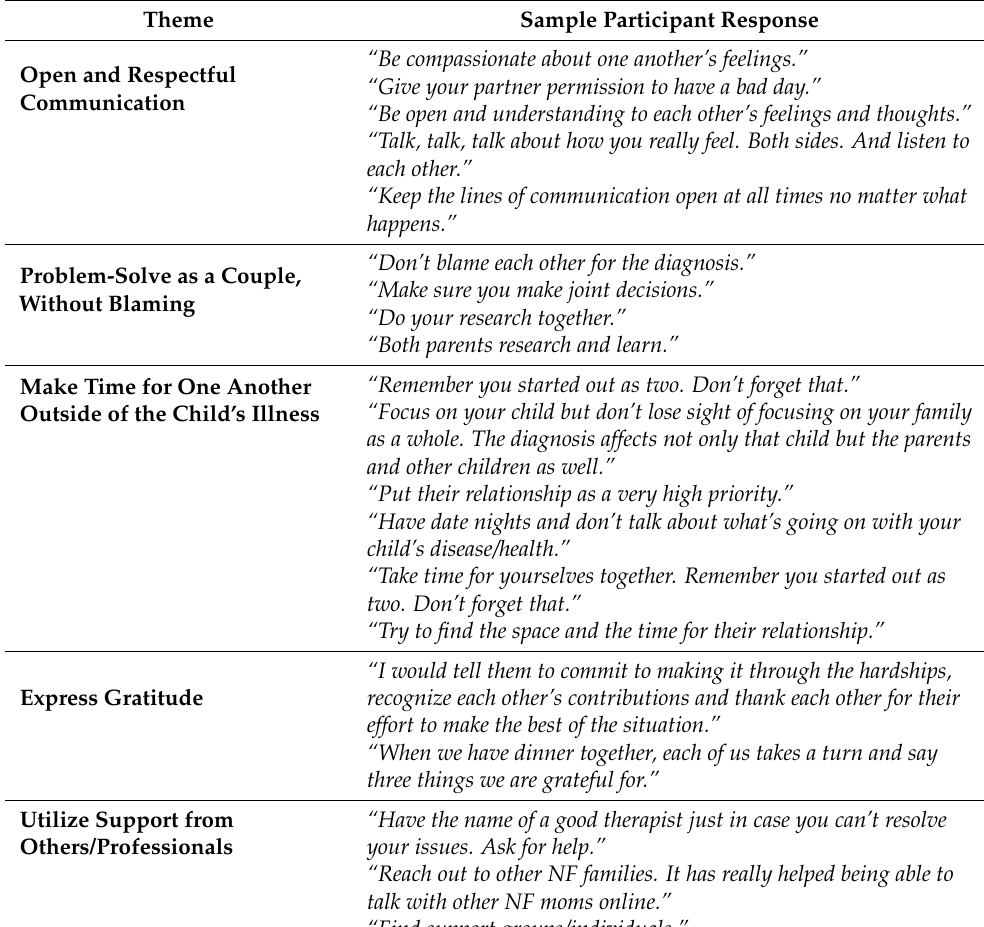
Table 3. Suggested Means of Strengthening the Parental